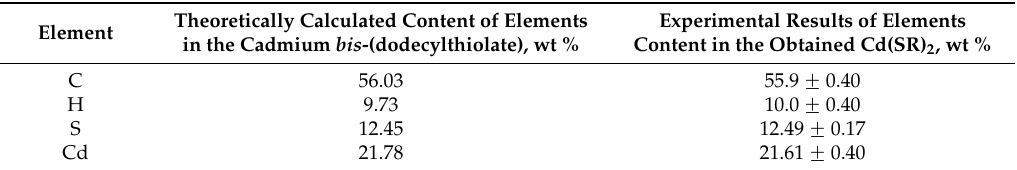
Table 2. Elemental composition of Cd(SR) 2